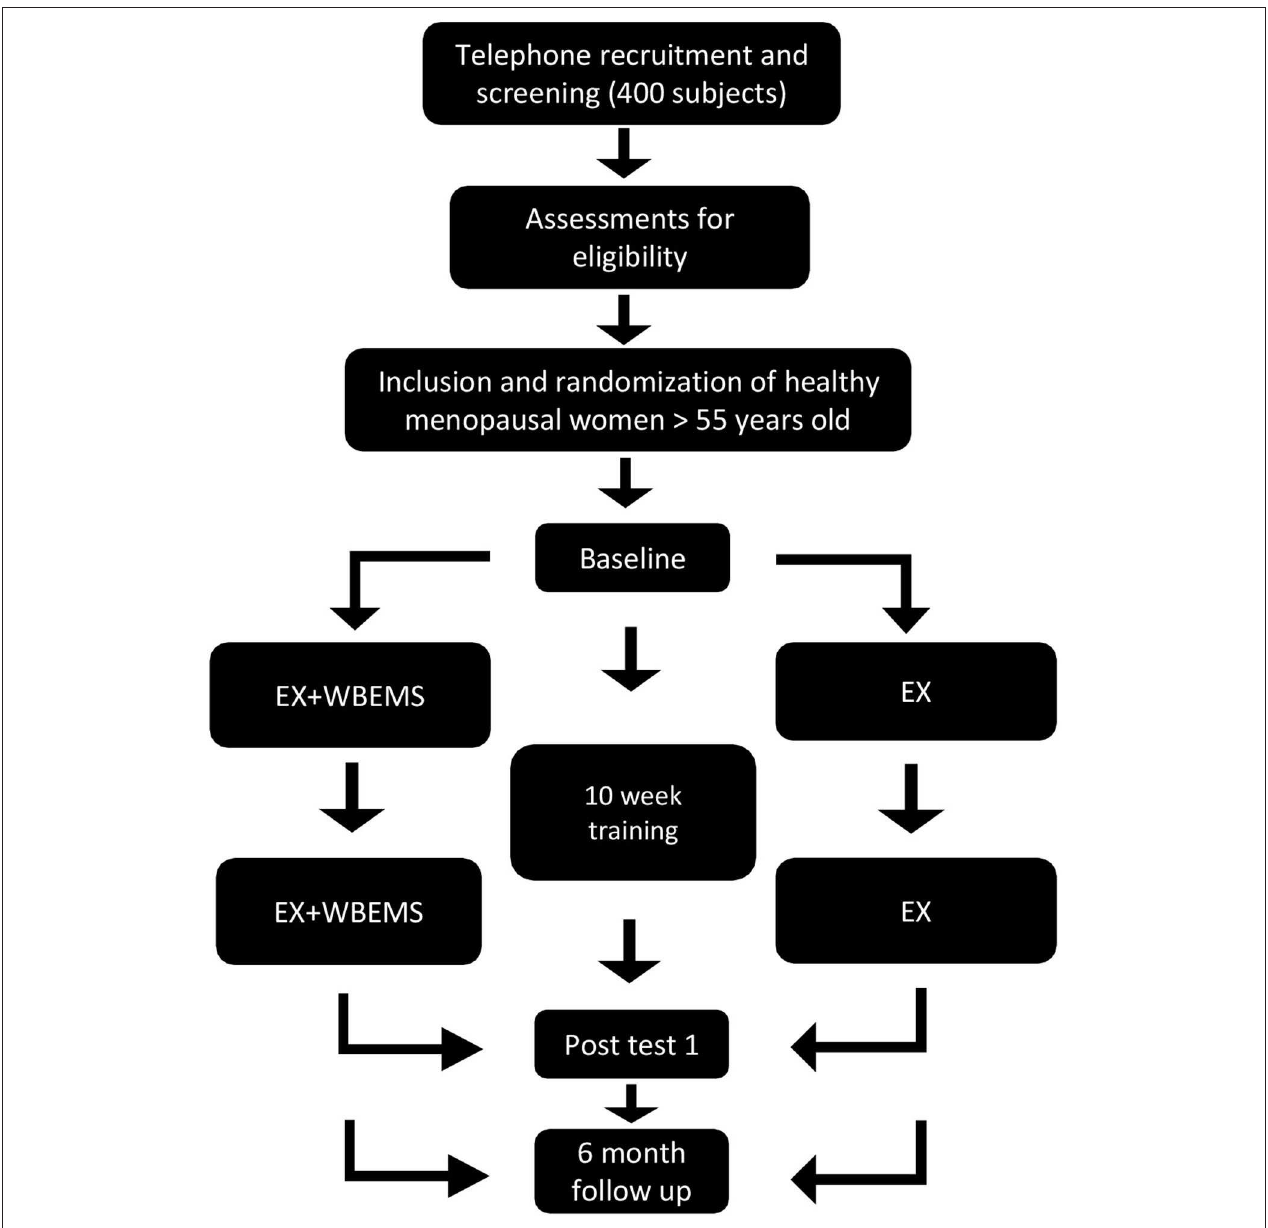
FIGURE 1 | Experimental design